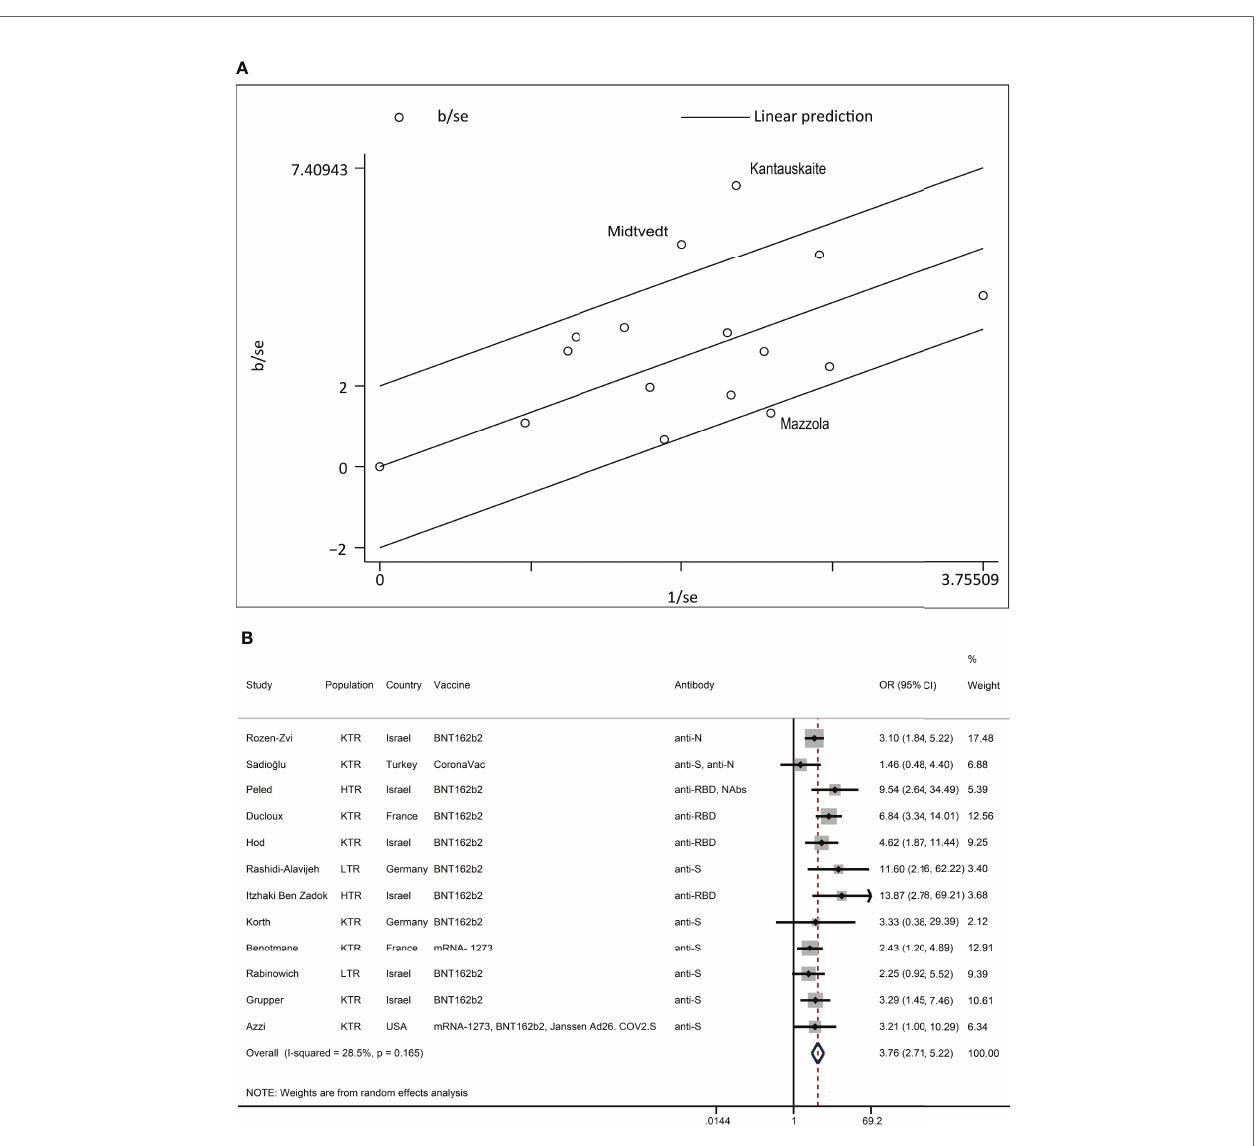
FIGURE 5 | Heterogeneity exploring of MPA/MMF. (A) In the Galbraith plot of MPA/MMF for heterogeneity exploration, hollow circles outside the parallel reference line represent studies that were considered possible sources of heterogeneity. (B) Reanalysis of MPA/MMF after the removal of possible sources of heterogeneity. The event was a negative antibody response after vaccination. N, the number of studies; KTR, kidney transplant recipients; LTR, liver transplant recipients; HTR, heart transplant recipients; anti-S, anti-spike protein antibody; anti-N, anti-nucleocapsid protein antibody; anti-RBD, anti-receptor-binding domain antibody; Nab, neutralizing